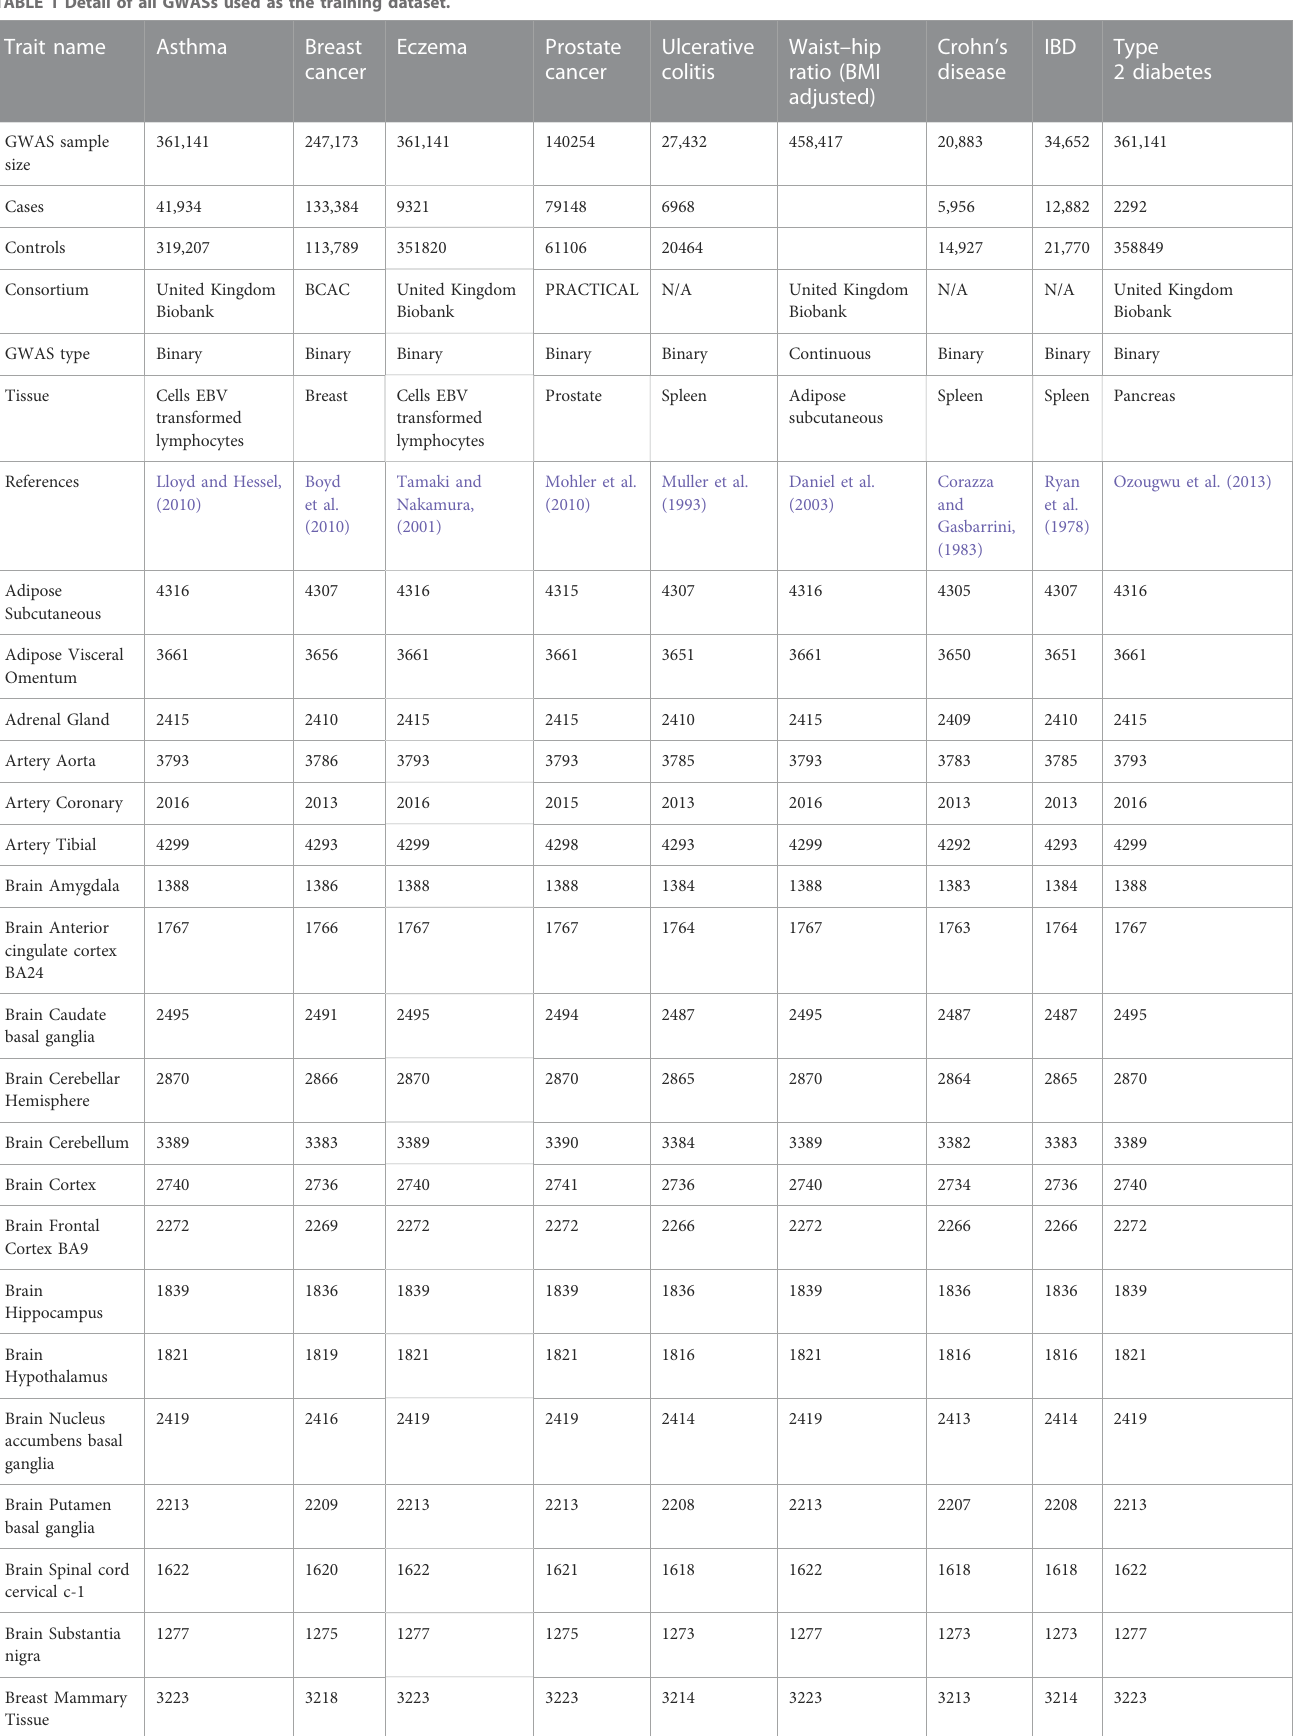
TABLE 1 Detail of all GWASs used as the training